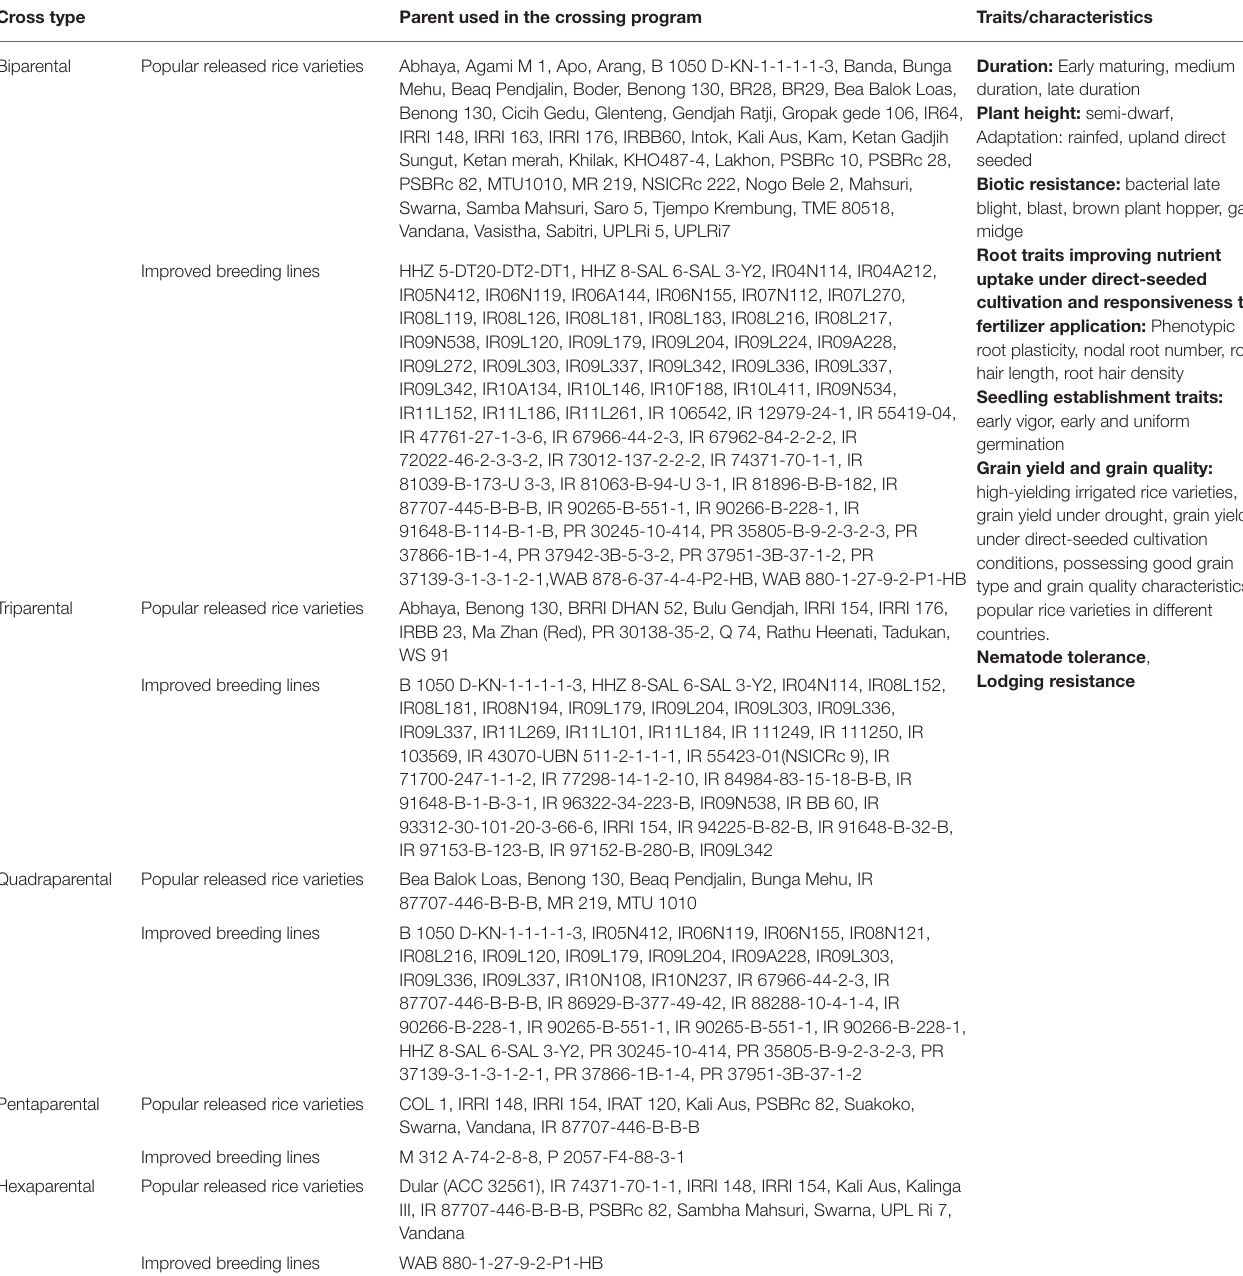
TABLE 1 | Detailed information on trait characteristics and parents used to develop breeding lines in conventional breeding program. Cross